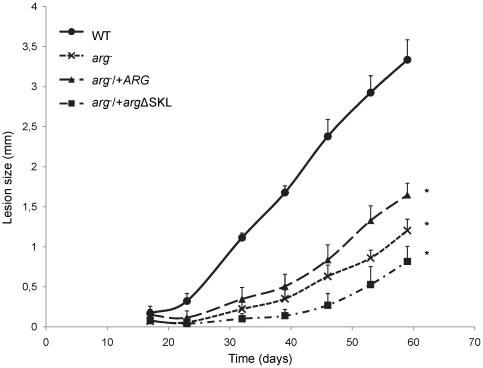

L. amazonensis in vivo infectivity is impaired by lack of ARG and incorrect location.BALB/c mice were infected in the posterior left footpad with 106 stationary phase promastigotes cells of L. amazonensis wild type (WT), ARG knockout (arg
−) and the add-backs arg
−/+ARG and arg
−/+argΔSKL parasites, and lesion sizes were monitored weekly. Data are presented as the means (+/− SD) of 5 infected mice and are representative of at least 2 different strains of null and add-backs mutants.* p<0.005 (Two-way ANOVA).